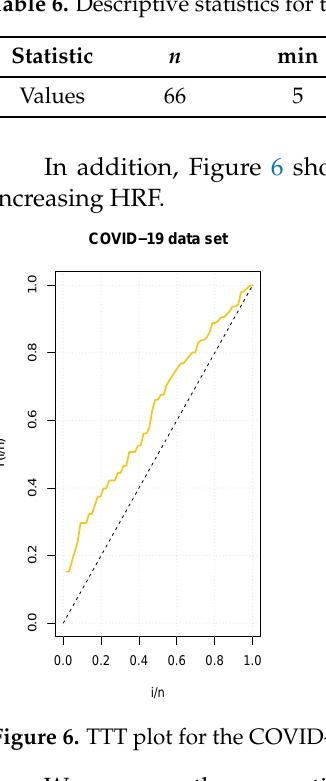
Table 6. Descriptive statistics for the COVID-19 dataset.